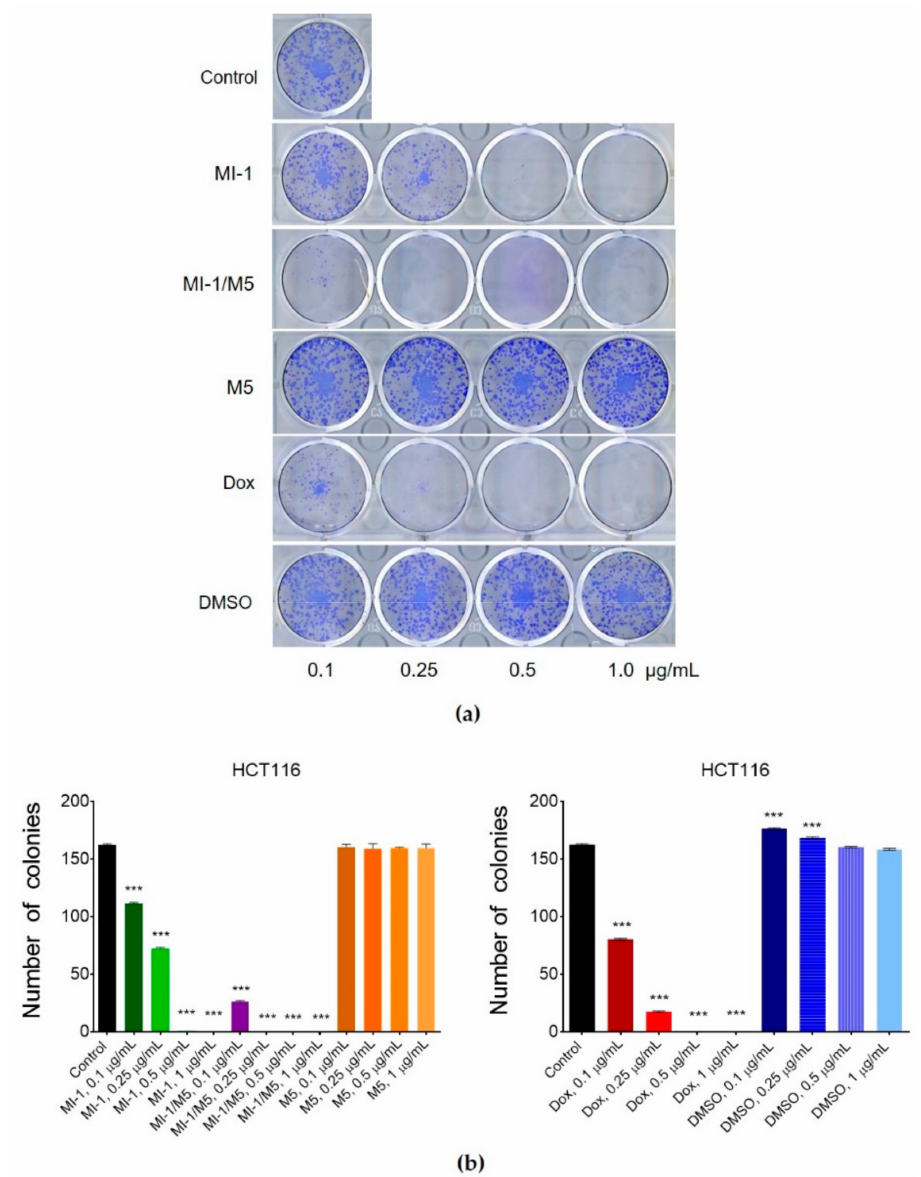
Figure 5. The effect of maleimide derivative MI-1, its complex with polymeric carrier (MI-1/M5), free polymeric carrier poly (PEGMA- co -DMM) (M5), doxorubicin (Dox), and solvent DMSO on clonogenic ability of HCT116 cells under 7 days of cells exposure: ( a ) The representative pictures of colonies formed in the 12-well plates; ( b ) Number of colonies formed by HCT116 cells. Data are presented as the mean ± SD. *** p < 0.001 compared with control (non-treated) cells. Thus, the MI-1/M5 complex was more efficient compared with free MI-1 in suppres- sion of the malignant phenotype (colony formation) of human colon carcinoma HCT116